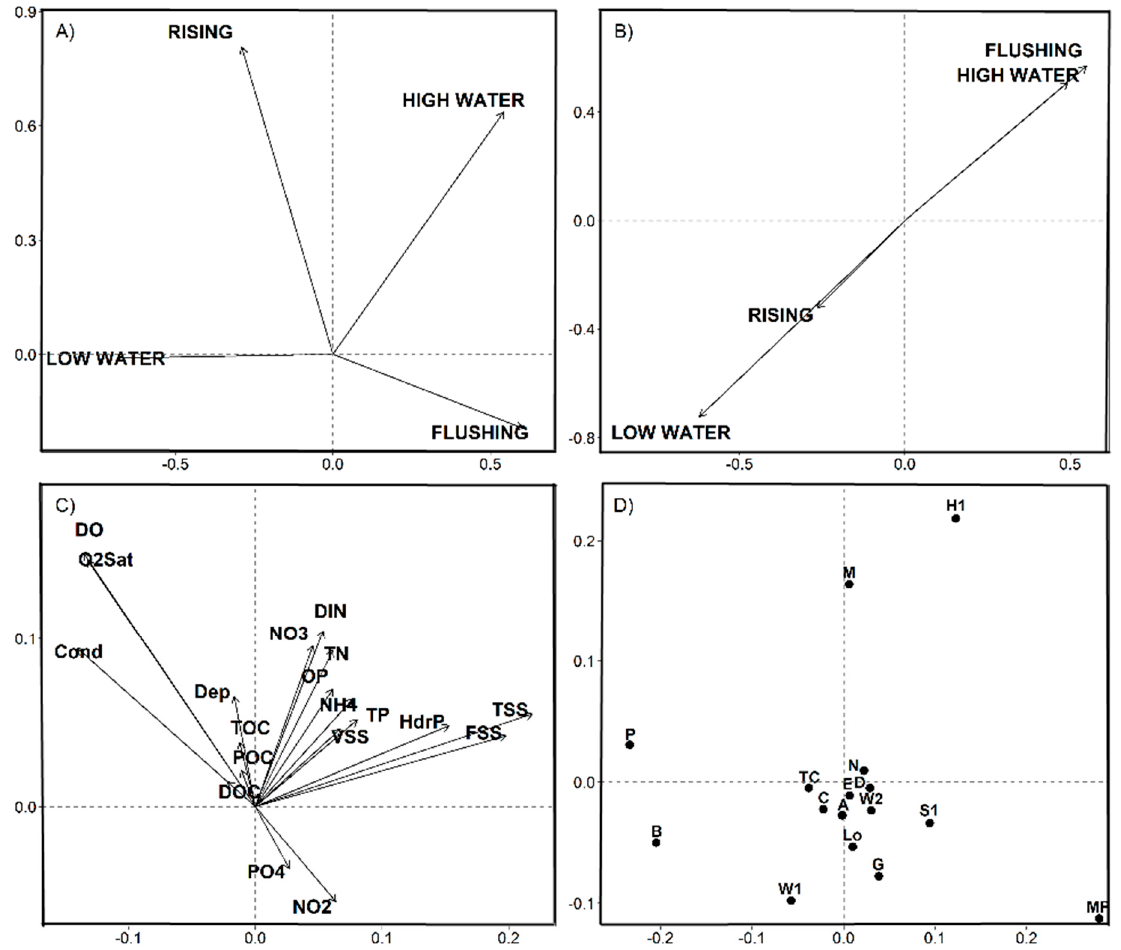
Figure 3. STATICO graph. The length of arrows ( A – C ), or distance from the center ( D ) indicates the strength of a relationship. Interstructure graph (A), weight of each hydrological period ( B ), environmental and nutrients compromise ( C ), species compromise ( D ).